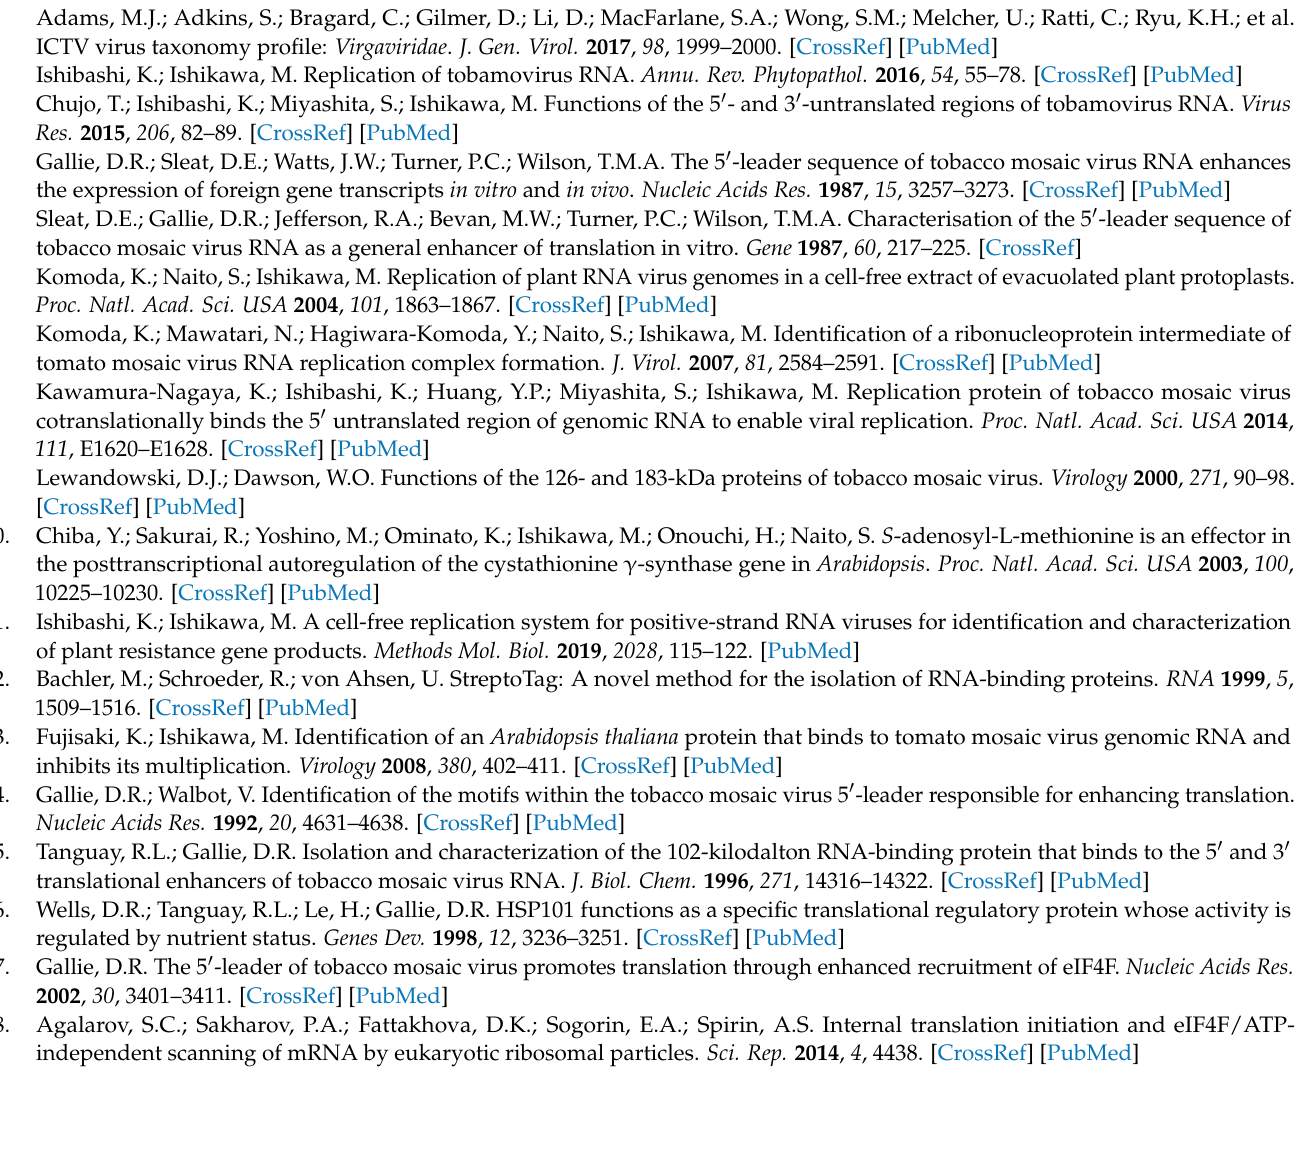
Figure S3: Relative band intensity of viral replication product (related to Figures 3 and